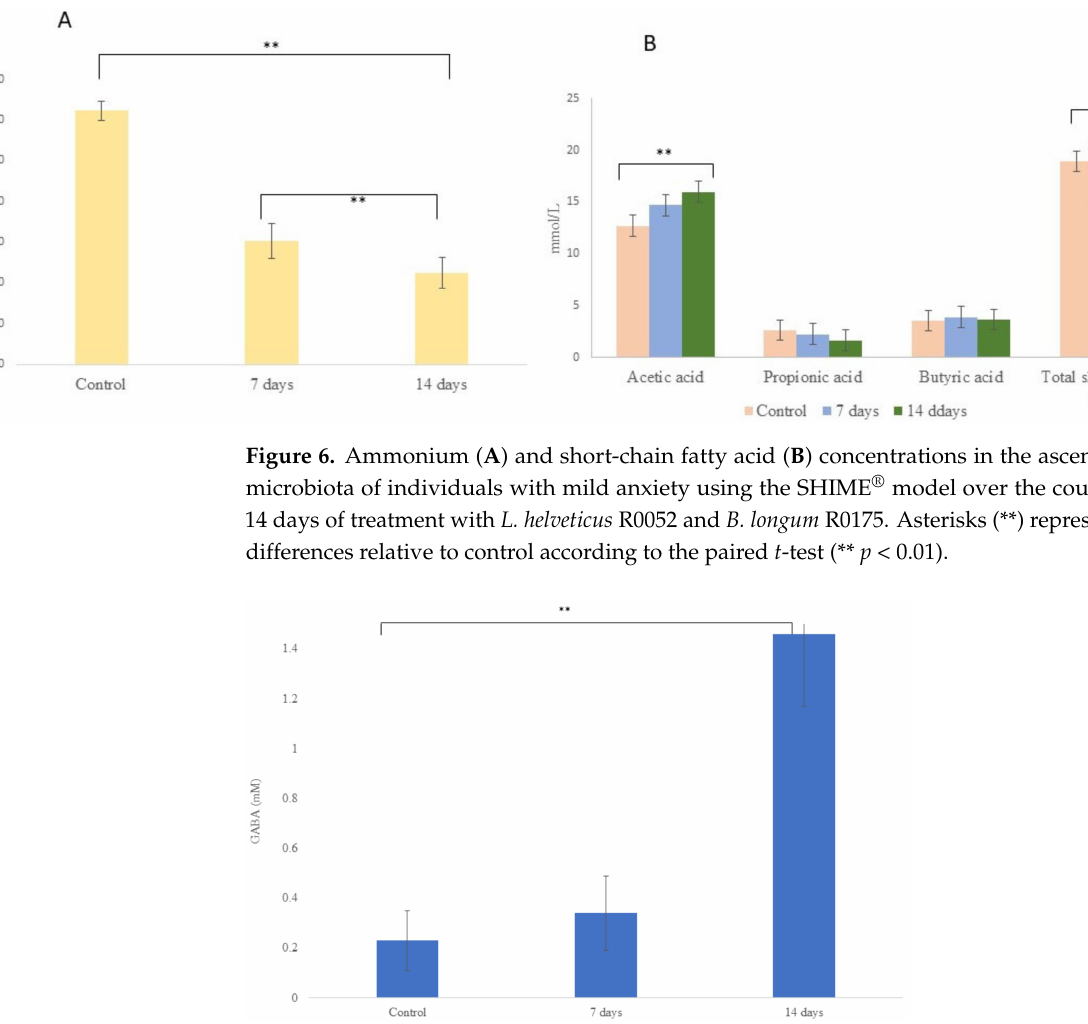
Figure 7. Gamma-Aminobutyric Acid (GABA) production in the ascending colon in microbiota of individuals with mild anxiety using the SHIME ® model over the course of the 7 or 14 days of treatment with L. helveticus R0052 and B. longum R0175. Asterisks (**) represent significant differences relative to control according to the paired t -test (** p <